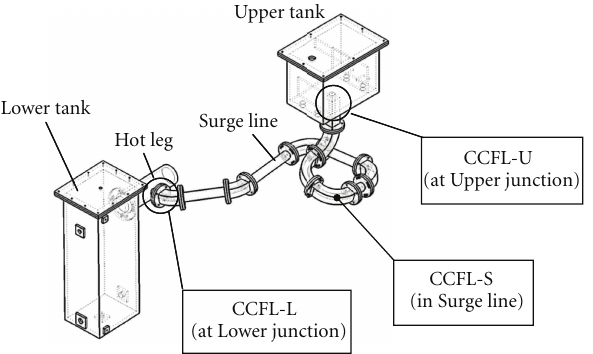
Figure 4: Flow limitation locations and CCFL